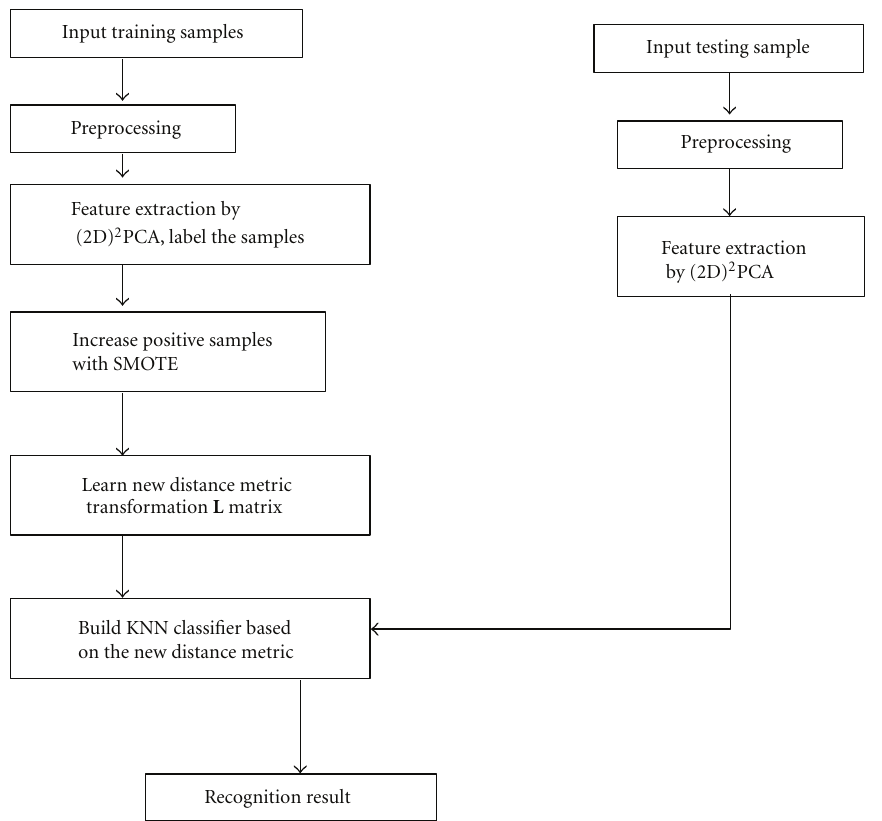
Figure 2: The proposed framework for finger vein